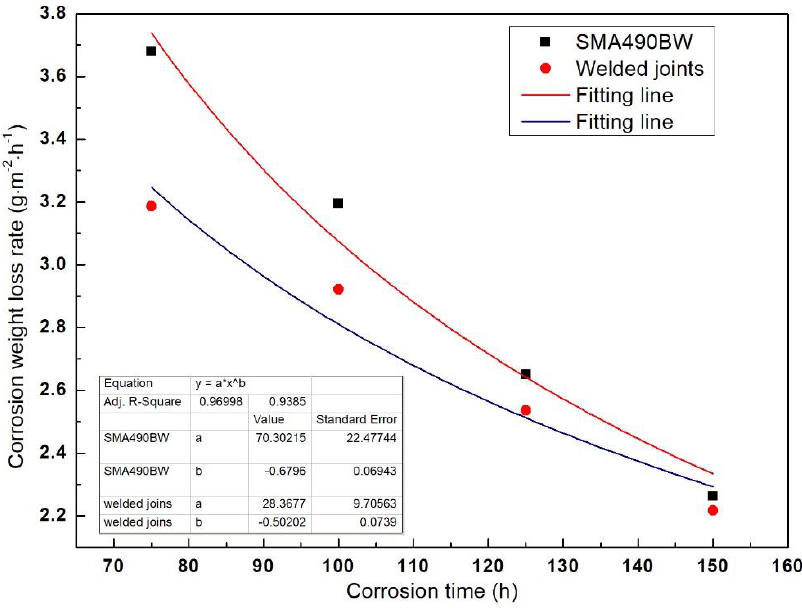
Figure 2. Fitting curve of the specimen’s corrosion weight loss rate as a function of corrosion time.